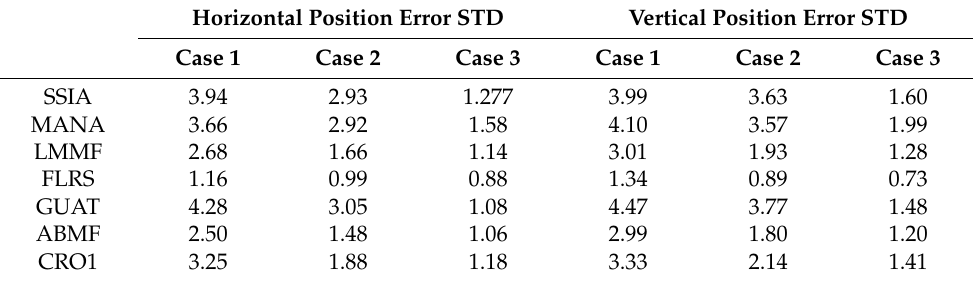
Table 6. One month STD of horizontal and vertical positioning errors in September